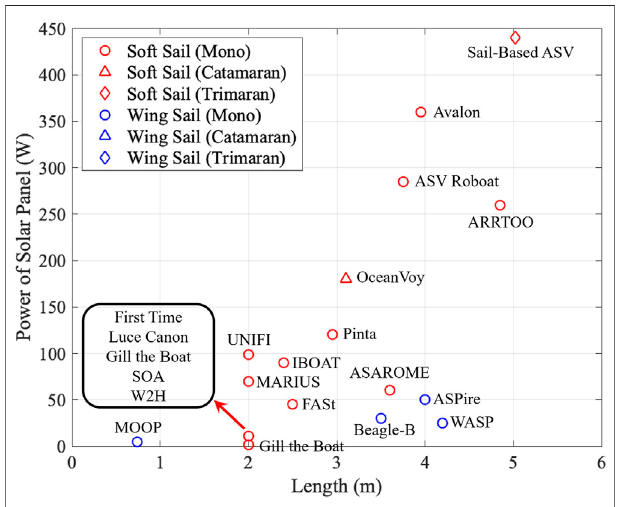
FIGURE 7 | Correlation between sailboat length and Watts on solar panels.